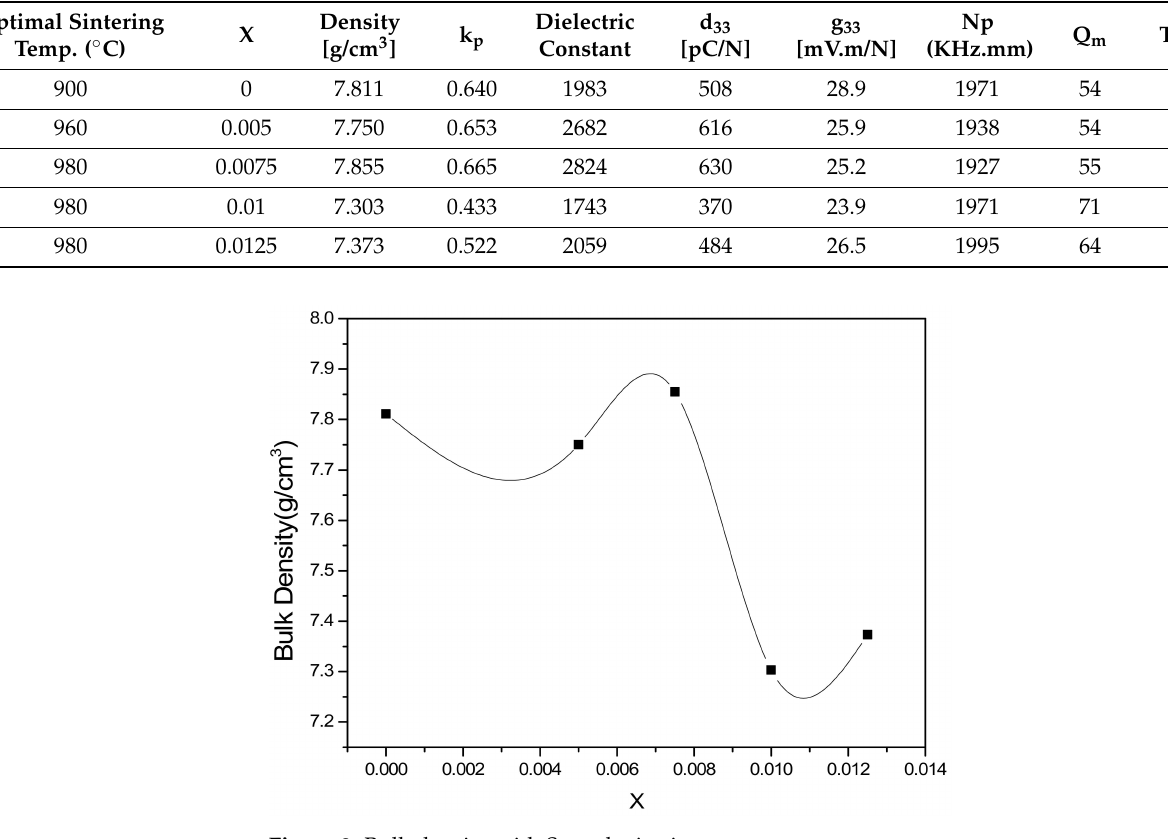
Figure 3. Bulk density with Sm substitution.